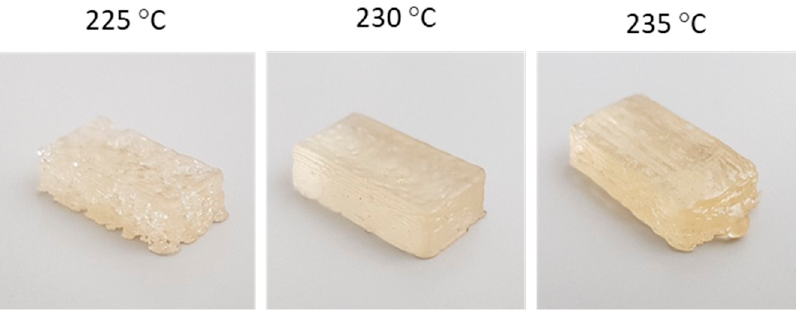
Figure 8. Pictures of the 3D printed SH-TPU samples of approximately 10 × 20 × 5 mm.